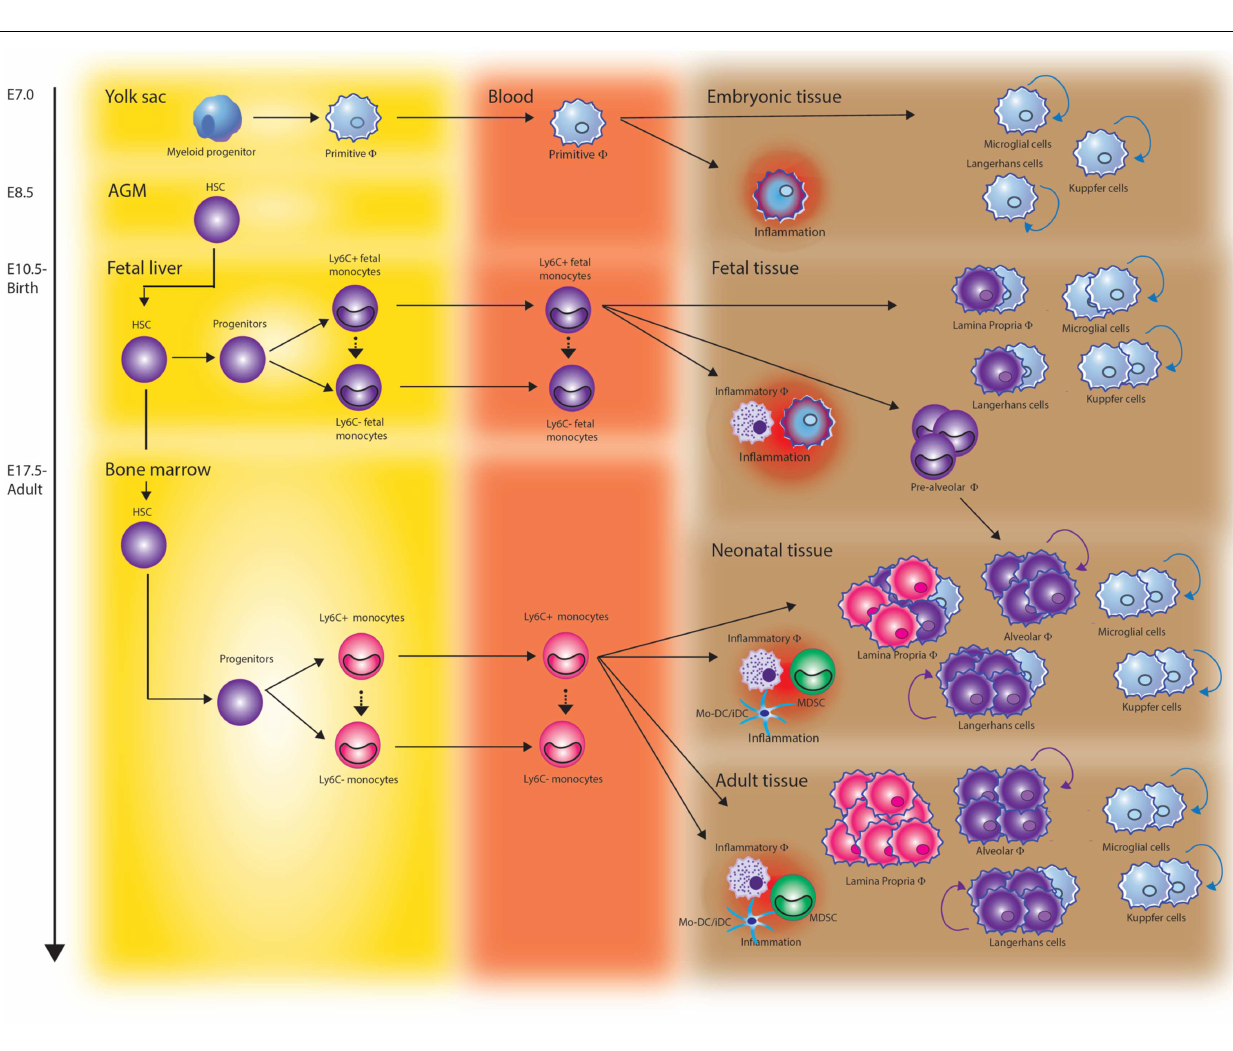
FIGURE 1 |The origin of monocytes and macrophages throughout development .Tissue resident macrophages arise at different stages of development and derive from at least three different sources. During early embryonic development, yolk sac-derived myeloid progenitors give rise to microglia in the brain, Kupffer cells in the liver, and Langerhans cells in the skin. Once fetal liver hematopoiesis has started (E10.5 in mice), fetal liver-derived monocytes differentiate into tissue macrophages and contribute to the Langerhans cell pool in the skin and lamina propria macrophages in the gut.They also seed the lung just before birth. After